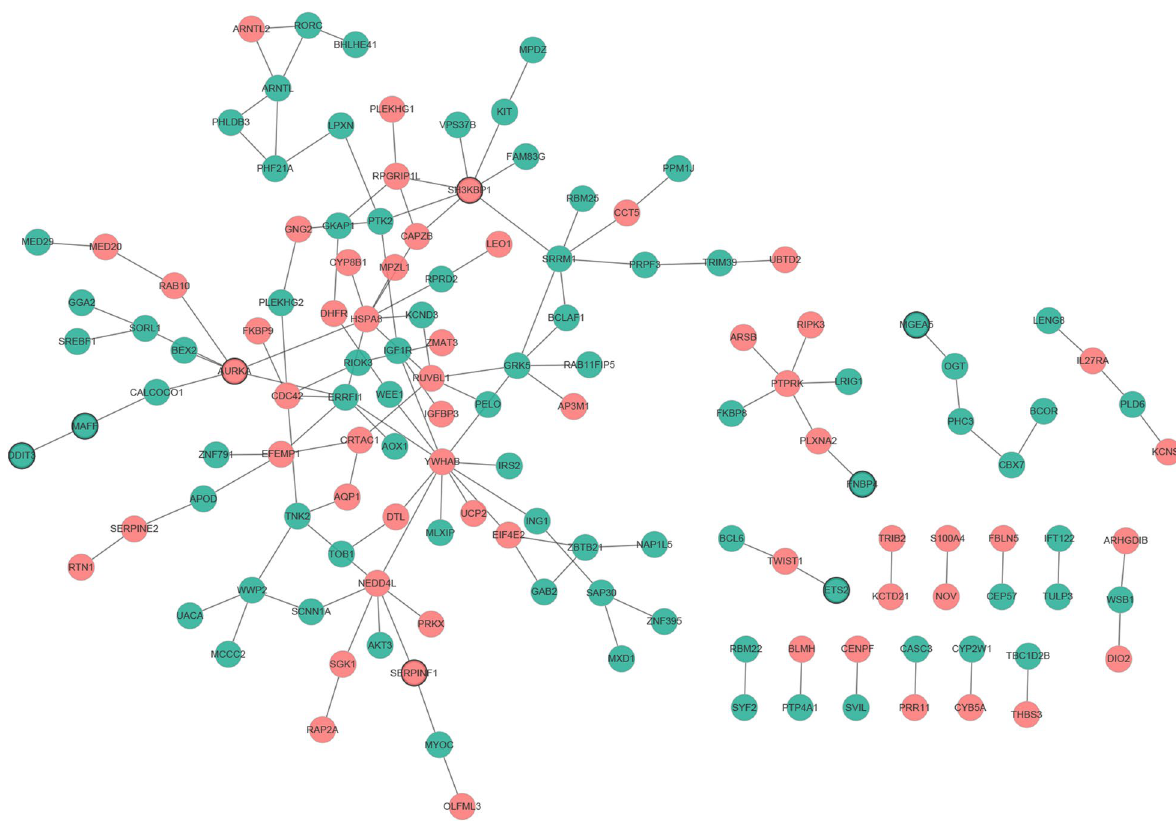
Fig. 3 OA-specific PPI networks